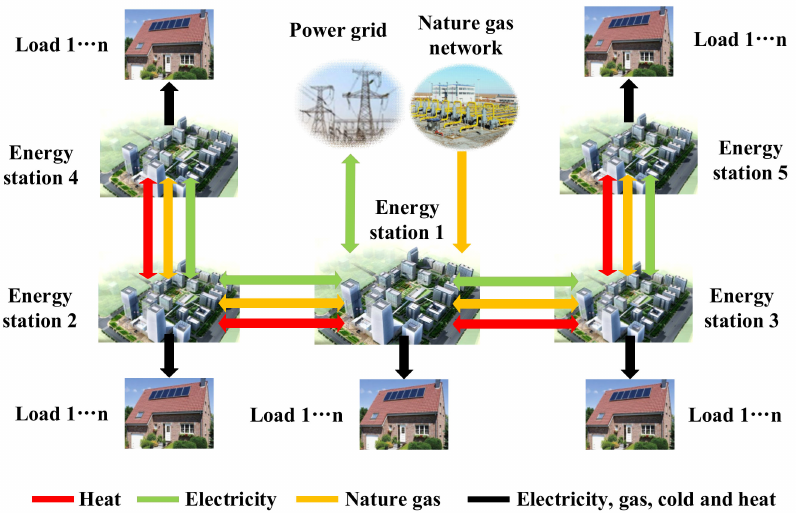
Figure 1. Energy flow network of an integrated energy system (IES).